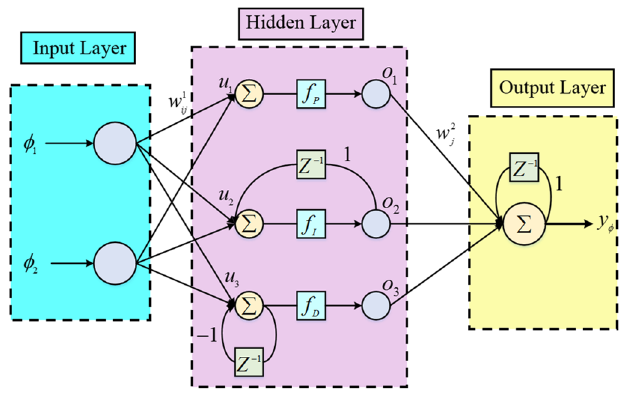
Figure 6. Network structure of PID neural network current controller.